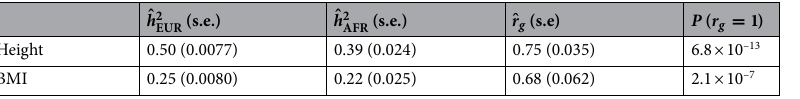
Table 1. Estimated ˆ r g between EUR and AFR using HapMap3 SNPs based on the ancestry specific GRMs for height and